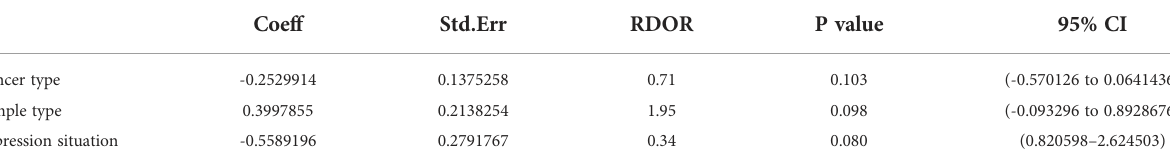
TABLE 2 Meta regression